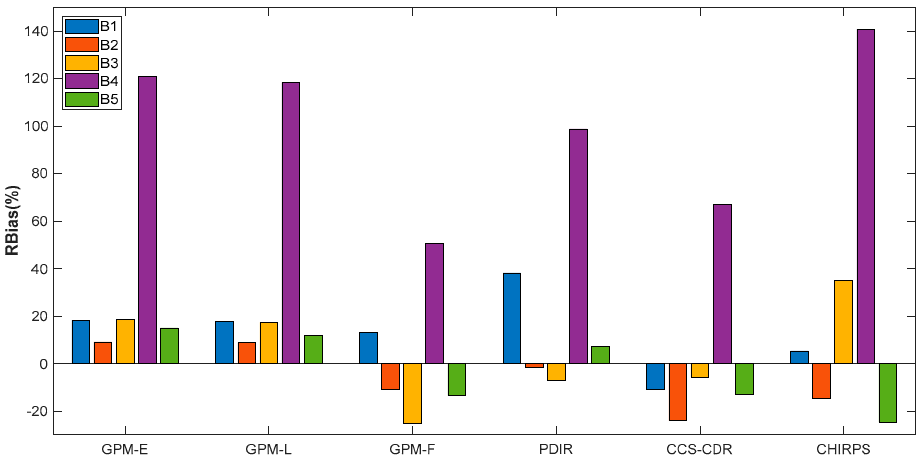
Figure 9. Relative bias of the six products for the five